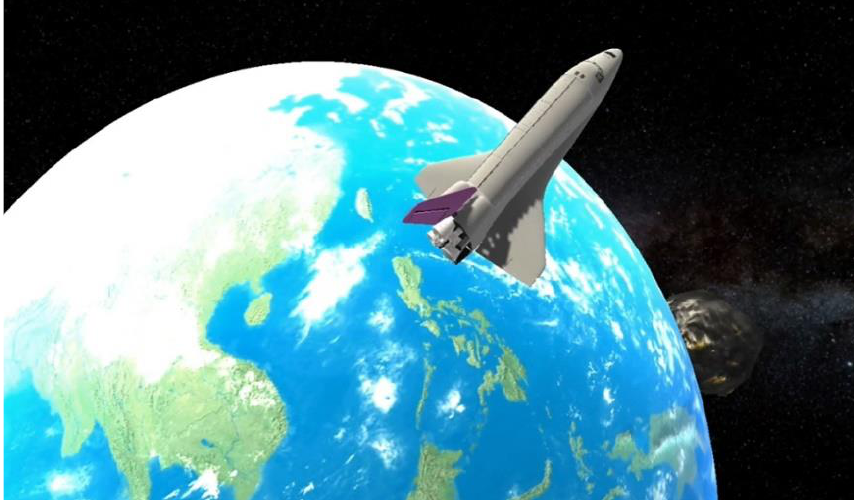
Figure 8. Spacecraft reaching outer space after launching from Earth. After entering the navigation stages, the monitor in front of the cockpit shows the current speed, the local time, and the remote time in the control room on Earth as well as the remaining nuclear fuel of the reactor (Figure 9). The learner can observe the difference between the running speed of the two clocks and compute the changes of time and space according to the spacecraft’s speed. For example, if the learner pilots the spacecraft at 0.9 times the speed of light to the destination, Proxima Centauri (about 4.3 light years from Earth), the challenge questions are: “How far is Earth away from Proxima Centauri as measured by the spacecraft pilot?” and “If the time in the control room on Earth passes by one minute, how long does the time in the spacecraft